Question: In one sentence, what is this figure communicating?
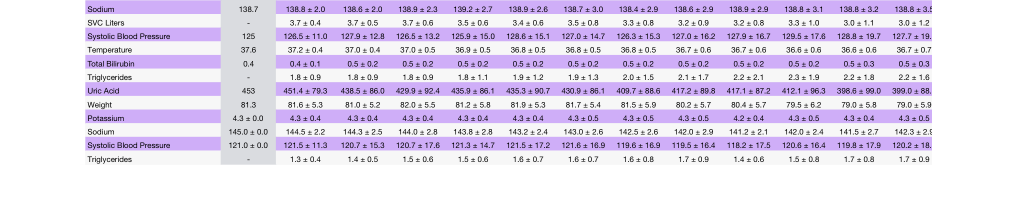
Answer: An example twin record for a single ALS patient is shown, which reports the mean and standard deviation of the twins for that patient. A sample of static baseline information is given at the top of the record. A sample of longitudinal outcomes predicted by the model are supplied as rows, with columns indicating the time in months since baseline visit.